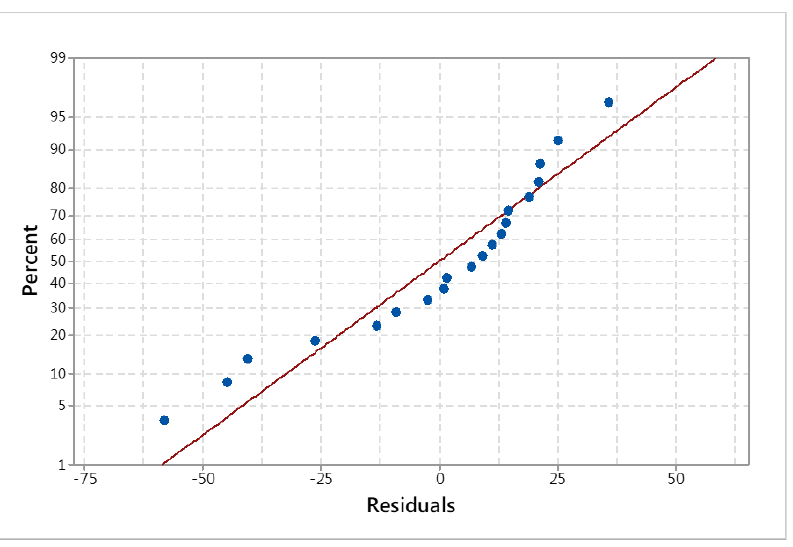
Figure 3. The residual analysis for A256 and ID Fitts in the Canon model shows poor fitting. The p -value, 0.035, was less than the criterion ( α = 0.05).